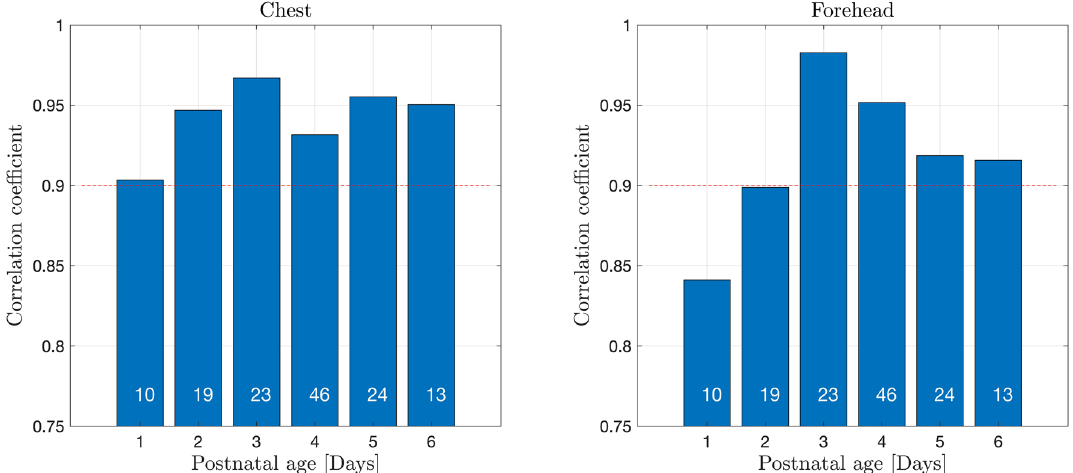
Figure 5. Correlation coefficients for t.c. bilirubin values measured with JM105 and JAISY in the forehead and chest, by postnatal age. Numbers in each bar indicate the number of